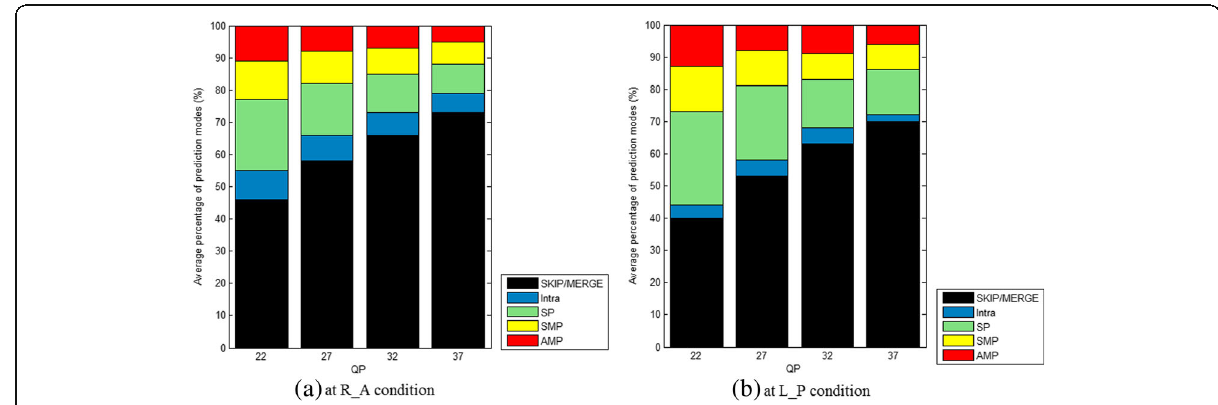
Fig. 2 Prediction mode distribution. a At R_A condition. b At L_P